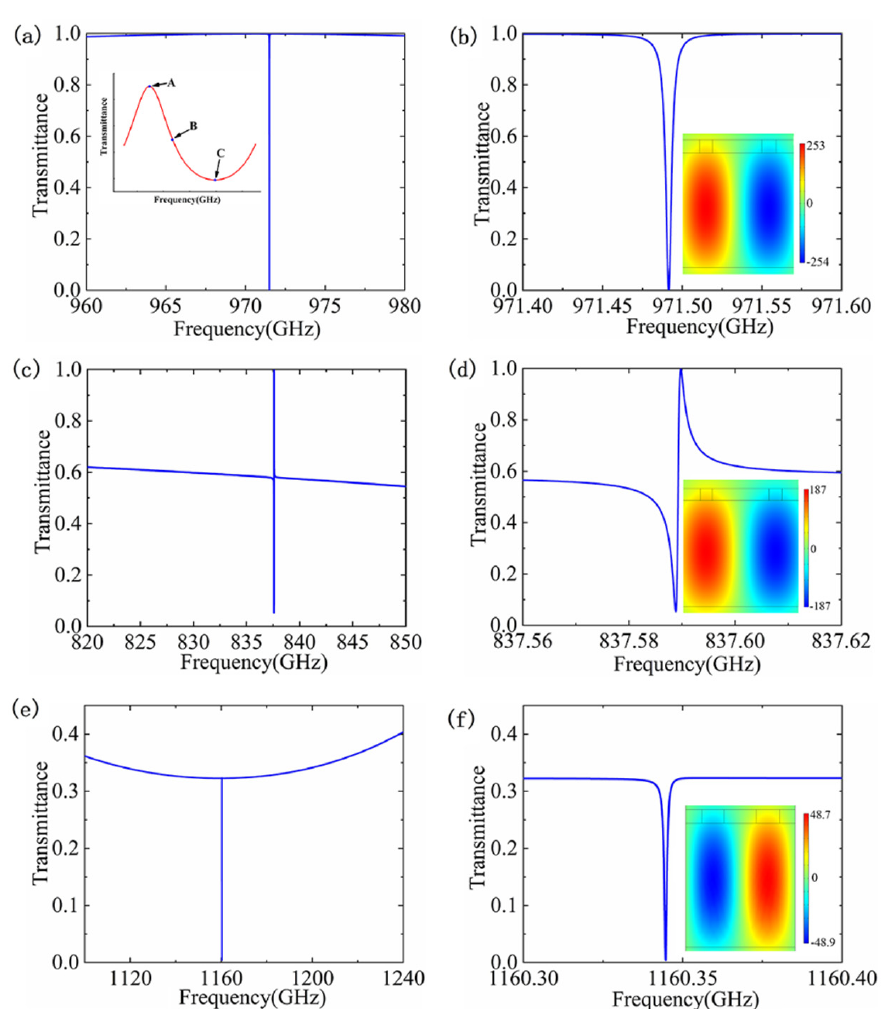
Figure 3. Transmission spectra at normal incidence when the QGM resonance happens at the peak ( a ), slope ( c ), and bottom ( e ) of the FP oscillations supported by the bare slab structure. ( b , d , f ) present the enlarged image close to the QGM resonance, respectively, as well as the real part of E z distribution across the slab for each QGM. The inset in ( a ) illustrates the transmission spectrum for the FP oscillations, where three points marked as A, B and C labels the position of the FP peak, slope, and bottom.